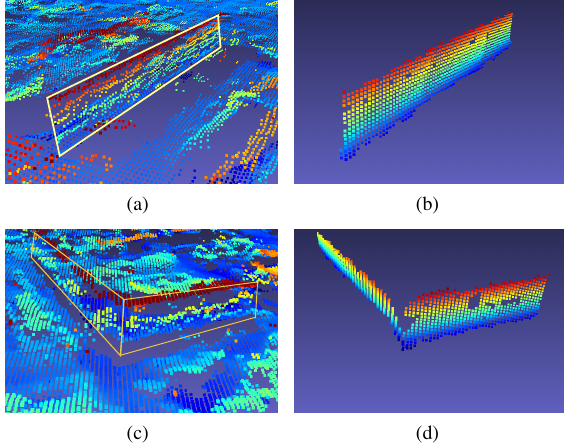
Figure 12: Examples of facade reconstructions. (a) and (c) show the original points, (b) and (d) show the reconstructed points after applying our extraction method. We have manually outlined the facades in the original point cloud for a better